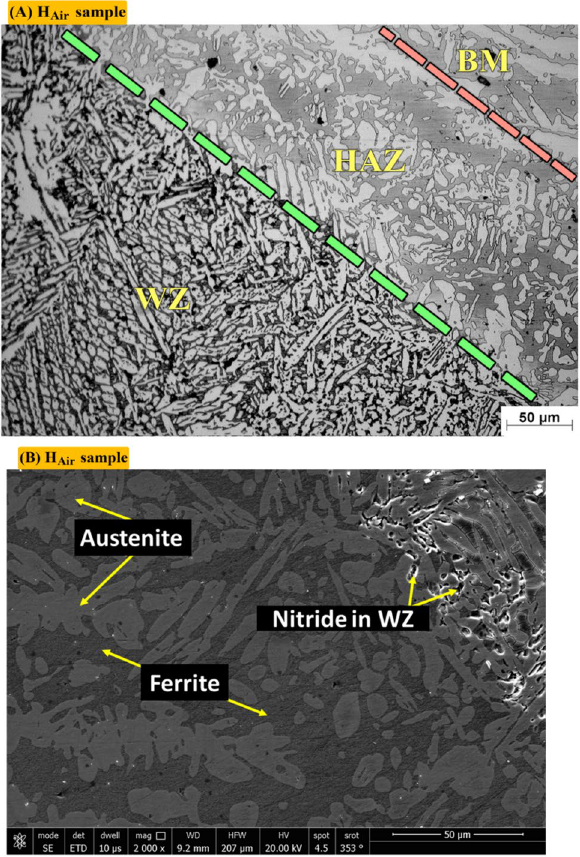
Figure 11. Optical and SEM micrographs of Heat effected zone of sample (H Air ) not protected during PWHT